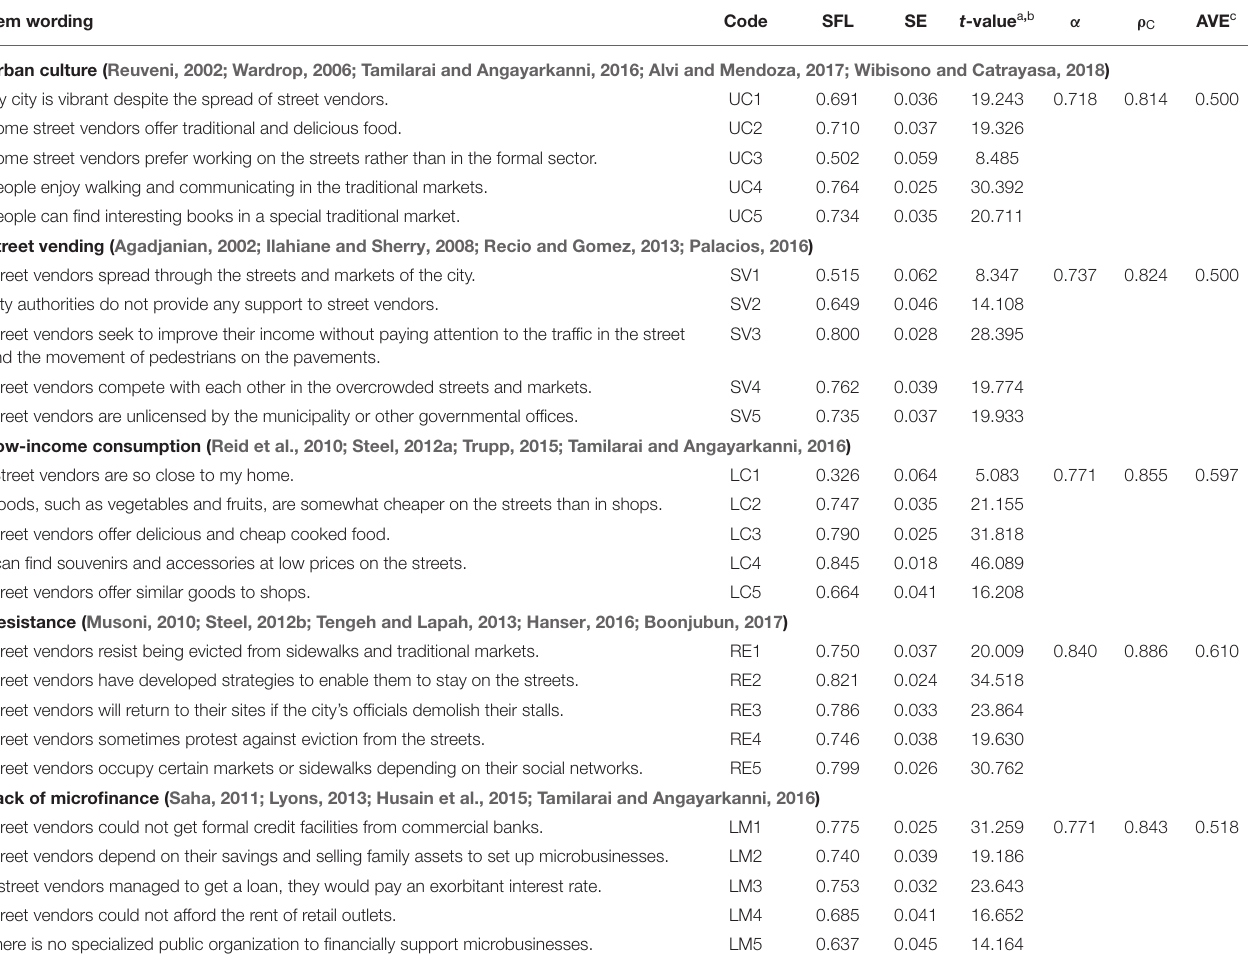
TABLE 1 | Measurement model